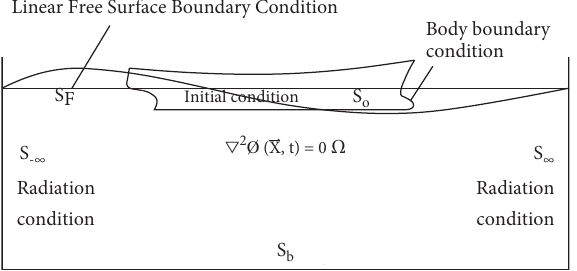
Figure 3: Hydrodynamic boundary domain and associated con- ditions ( S denotes surface of relevance to boundary